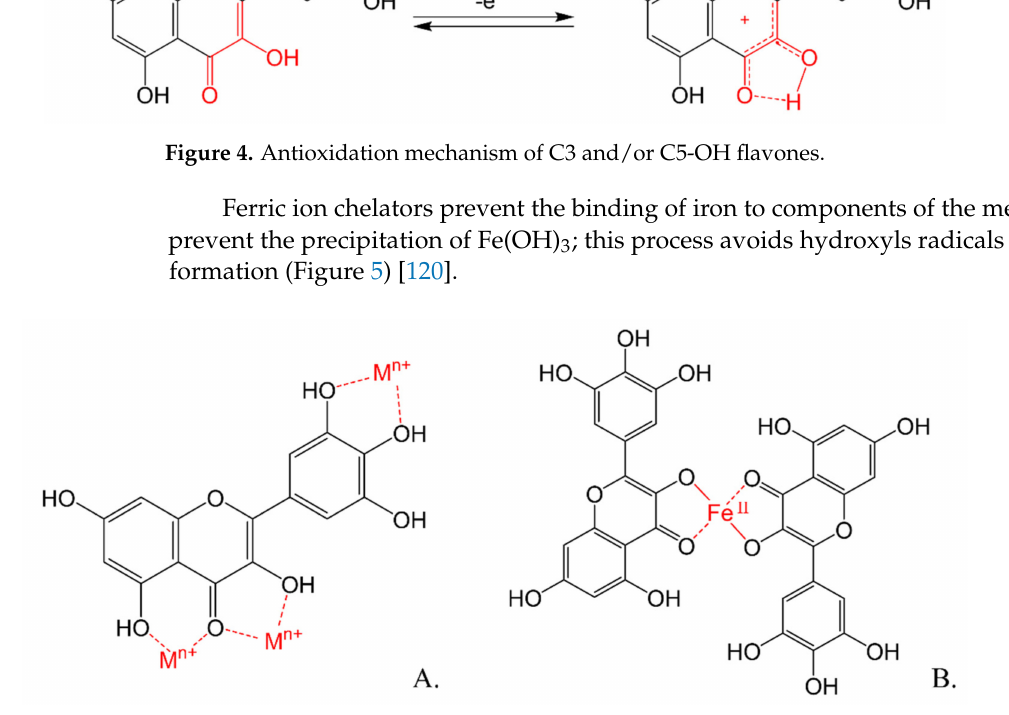
Figure 5. ( A ) Possible sites for trace metals binding. ( B ) Chelation of Fe, forming a chemical complex of myricetin. Some requirements have been described for flavonoids to have the ability to inhibit some oxidases, such as the OH group at least at C7 or one additional OH at C5, including a double bond between C2 and C3 in the benzopyrone ring. The catechol group in the B ring could be present to have inhibitory activity on xanthine oxidase (Figure 6). This enzyme catalyzes the oxidation of xanthine and hypoxanthine to uric acid [121–123]; this can be used as the base to synthesize inhibitors for this enzyme.